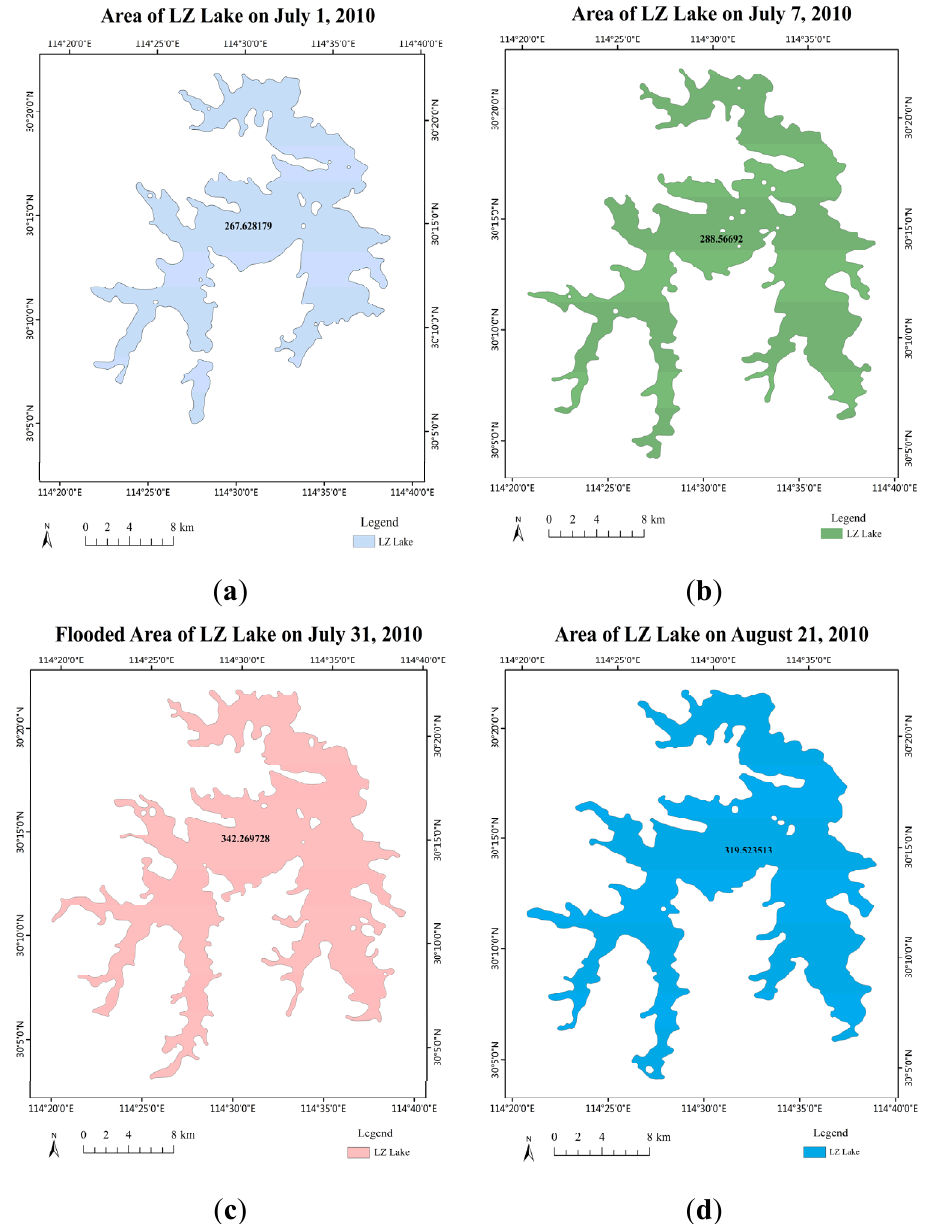
Figure 8. Areas of LZ Lake in different phases. ( a ) Area of LZ Lake on 1 July 2010 (Diagnosis phase); ( b ) Area of LZ Lake on 7 July 2010 (Preparedness phase); ( c ) Flooded area of LZ Lake on 31 July 2010 (Response phase); ( d ) Area of LZ Lake on 21 August 2010 (Recovery